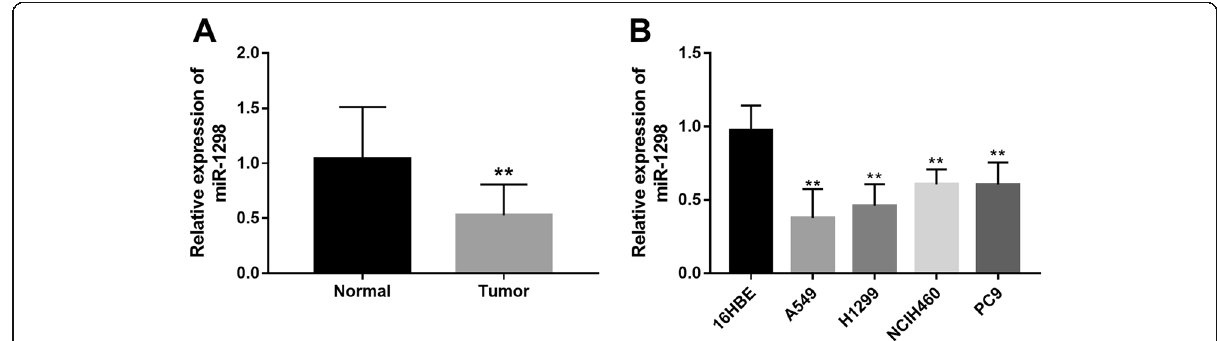
Fig. 1 Decreased expression of miR-1298 in NSCLC tissues and cell lines. A. Expression of miR-1298 in NSCLC tumor tissues was lower than that in the normal tissues. B. Expression of miR-1298 was downregulated in the four NSCLC cell lines (A549, H1299, NCIH460 and PC9) compared with the normal cell line (16HBE). ** P <